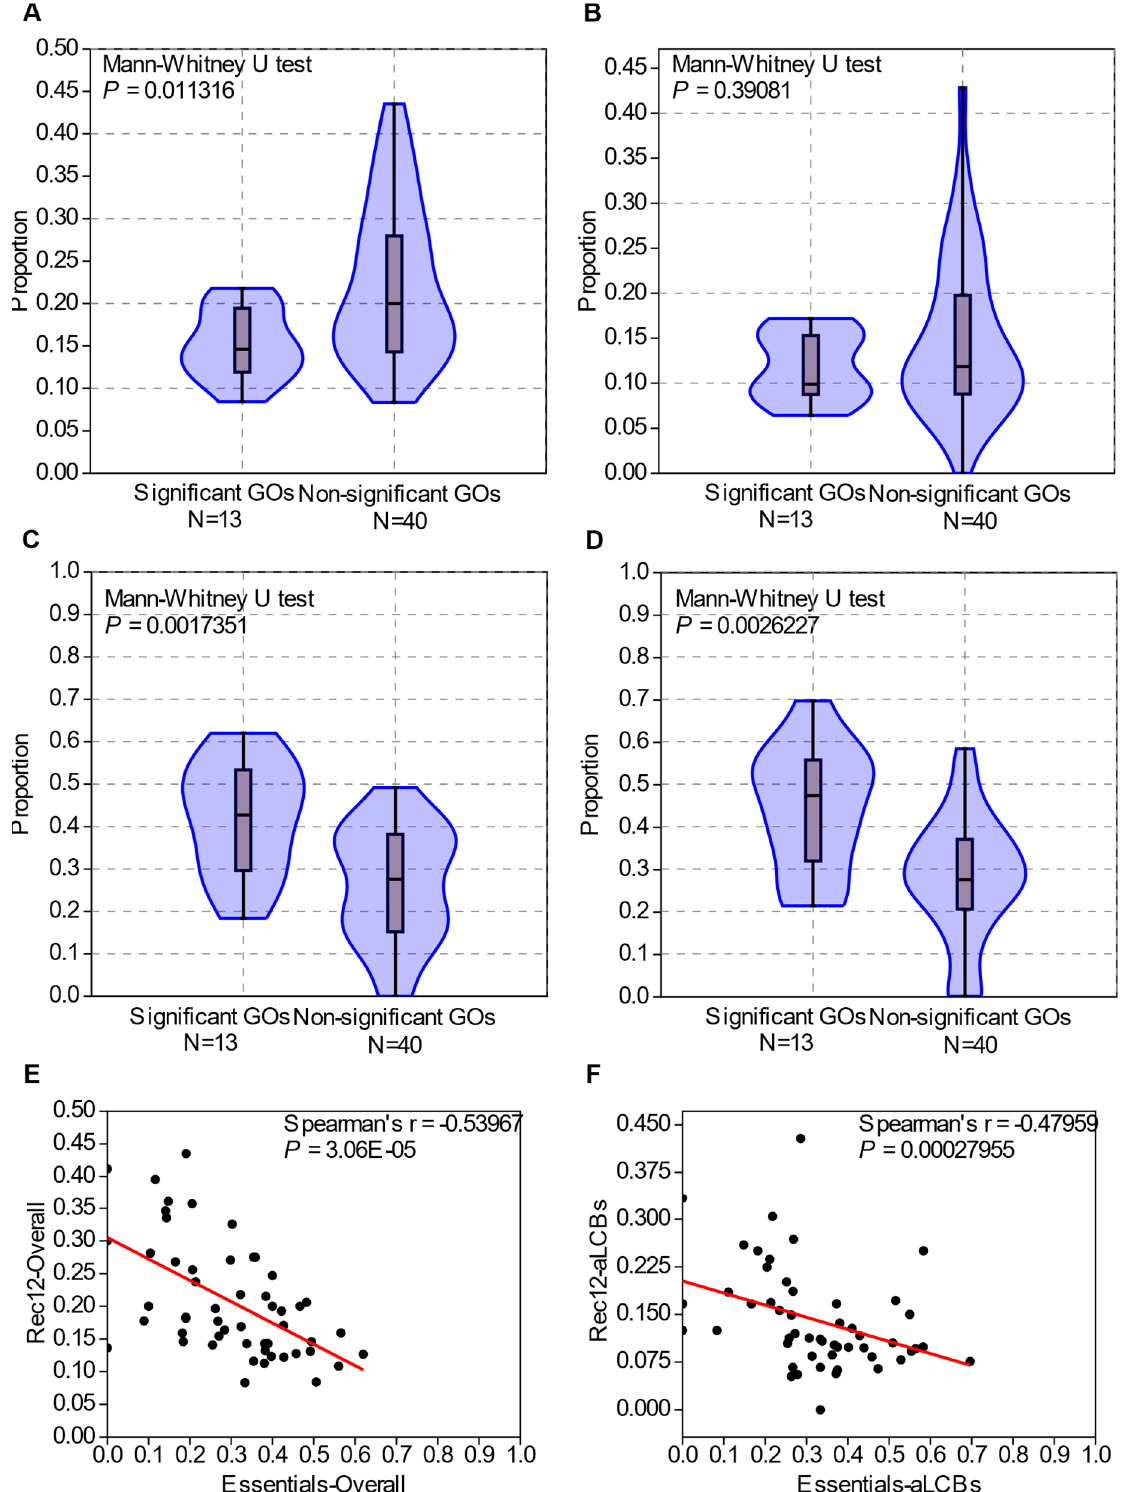
Figure 7. Density of Rec12 cleavage sites and of essential genes in the significant and non-significant GO categories. ( A ) Overall density of Rec12 sites in the 13 significant and 40 non-significant GO categories are significantly different. ( B ) Rec12 density only in the aLCBs proved to be not significantly different. ( C , D ) Density of essential genes in overall and in the aLCBs among the GO categories. There were significant discrepancies among the concerning values. ( E , F ) Correlation of the Rec12 site densities and essential gene densities. Black dots represent GO categories, red lines are regression lines. The data show moderate, but significant